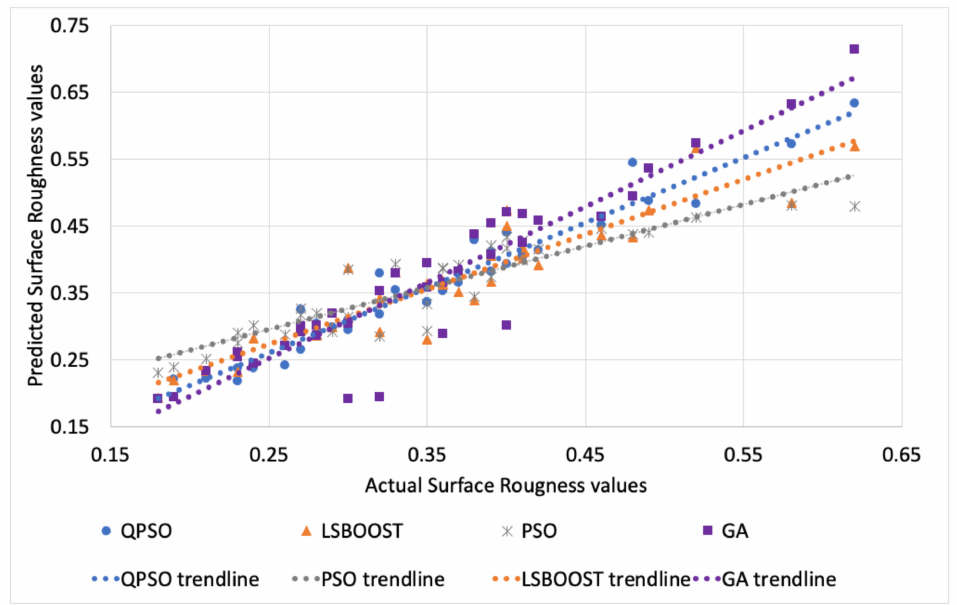
Figure 2. Actual values of the surface roughness vs. predicted values by QPSO, LSBoost, PSO and GA with R 2 trend